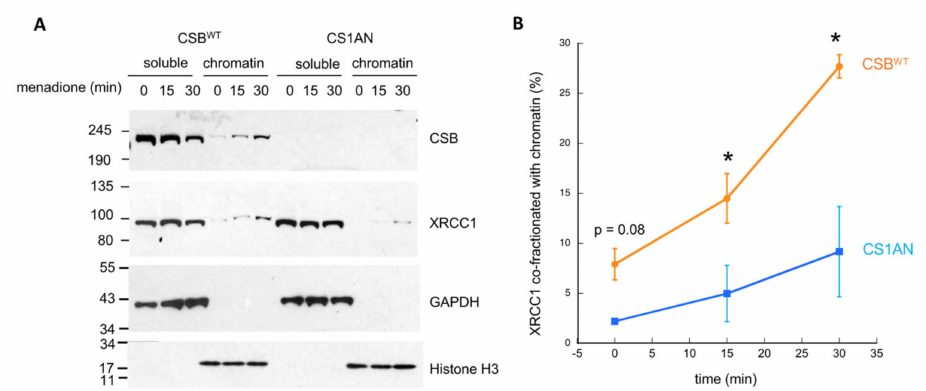
Figure 5. CSB increases the kinetics of XRCC1 association with oxidatively damaged chromatin. ( A ) Soluble and chromatin-enriched fractions from CSB WT and CS1AN cells, treated with 100 µ M menadione for the indicated time points, were resolved by SDS-PAGE and subjected to Western blot analysis. ( B ) Quantified Western blot signals were plotted as percent XRCC1 co-fractionating with chromatin. Shown are means +/ − SEM ( n = 3 biological replicates). *: p < 0.05.